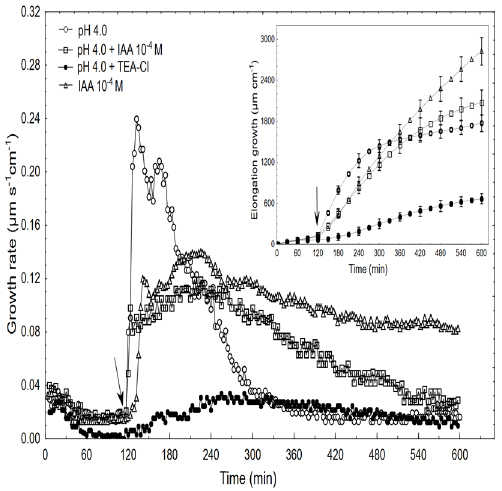
Figure 6. Effect of the acid buffer (pH 4) and its combination with the IAA or TEA-Cl on the growth rate (µm s − 1 cm − 1 ) and elongation (µm cm − 1 ) of the maize coleoptile segments. The coleoptile segments were first preincubated (over 2 h) in the control, after which this medium was changed for a new one containing the acid buffer or its combination with the IAA (10 − 4 M) or TEA-Cl (30 mM). The inset on the right side shows the total elongation over 10 h. The typical results were selected from six experiments. The adequate mean values are indicated in the text.